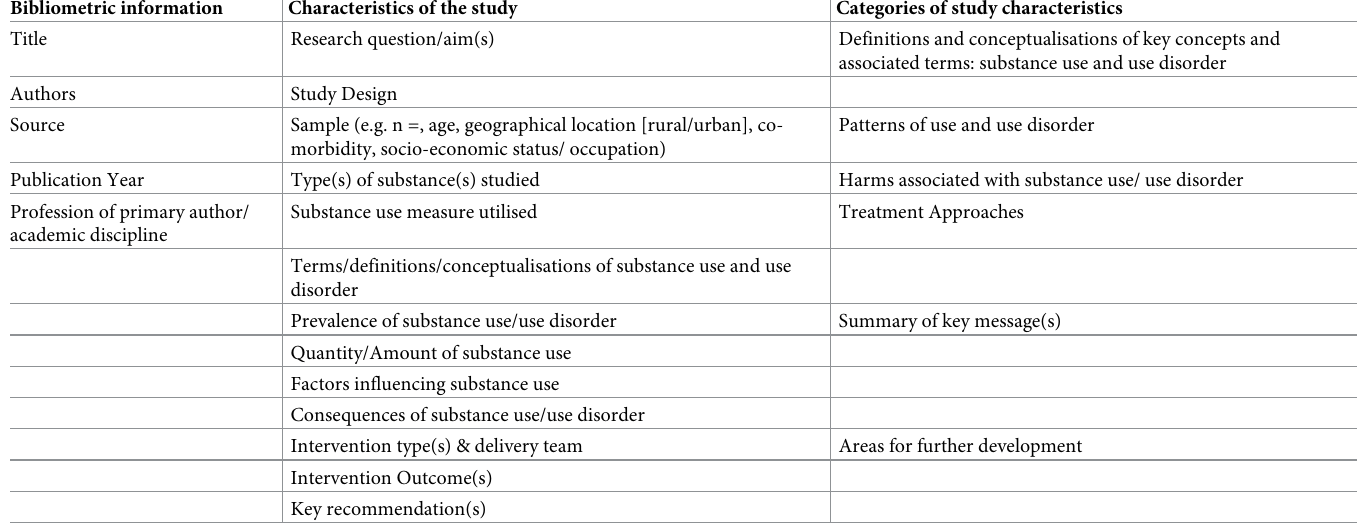
Table 2. Data extraction